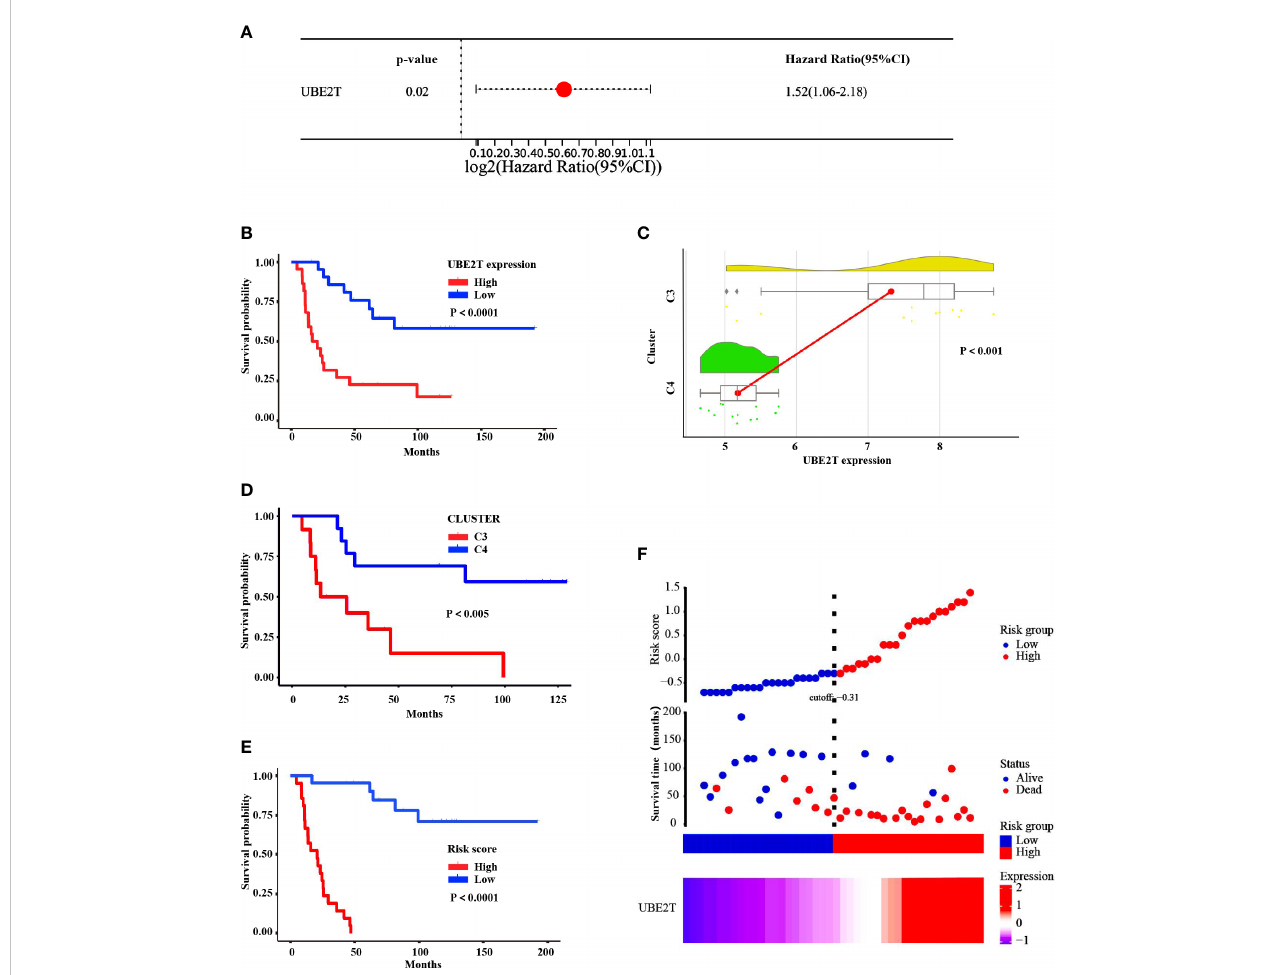
FIGURE 7 Correlation analysis between expression of UBE2T and prognosis in ES patients of the training cohorts. (A) HR and 95% CI of the core DEGs based on a unitvariable Cox regression analysis. (B) The Kaplan Meier survival curve demonstrated that the overall survival time of patients with UBE2T high expression was evidently shorter than low expression ( P <0.0001). (C) The raincloud diagram showed the expression of UBE2T in C3 was signi fi cantly higher than C4 ( P <0.001). (D) The K-M survival curve indicated that the survival time of C3 was signi fi cantly shorter than C4 ( P <0.005). (E) The K-M survival curve displayed that patients in the high-risk score group had considerably lower survival time than the low-risk group ( P <0.0001). (F) The distribution of risk score, survival status, and UBE2T expression level revealed that risk score increased as UBE2T expression increased, while survival rate decreased